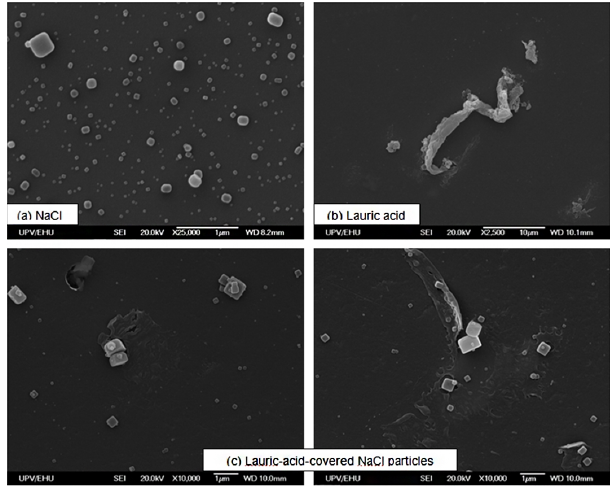
Figure 4. SEM images of: (a) pure NaCl particles; (b) pure LA particles; (c) NaCl particles covered with LA.